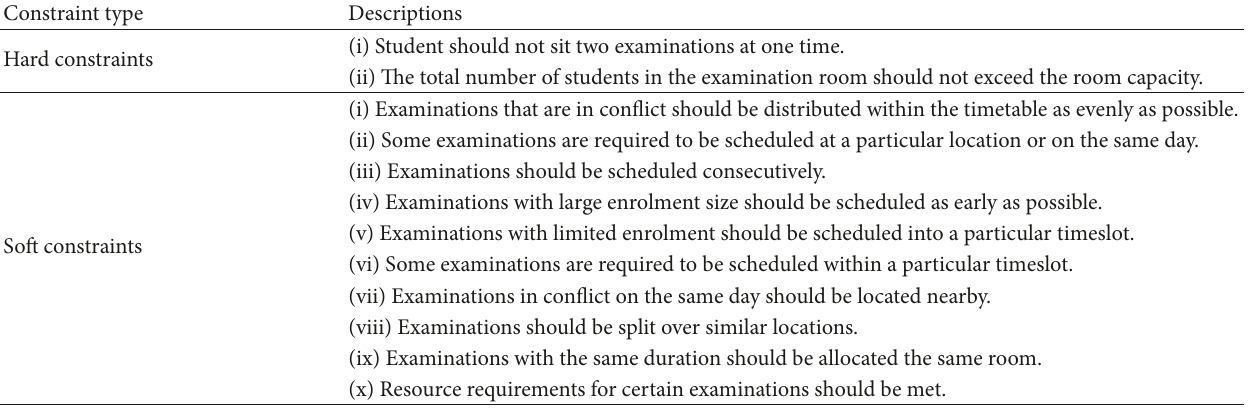
Table 1: The hard and soft constraints within the ETP adopted from Qu et al. [18].